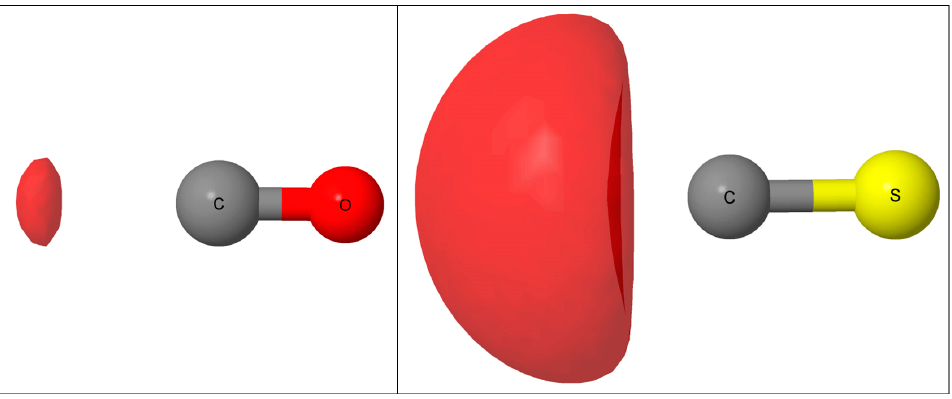
Figure 1. MEPs on the − 0.025 au isosurfaces of CO and CS.